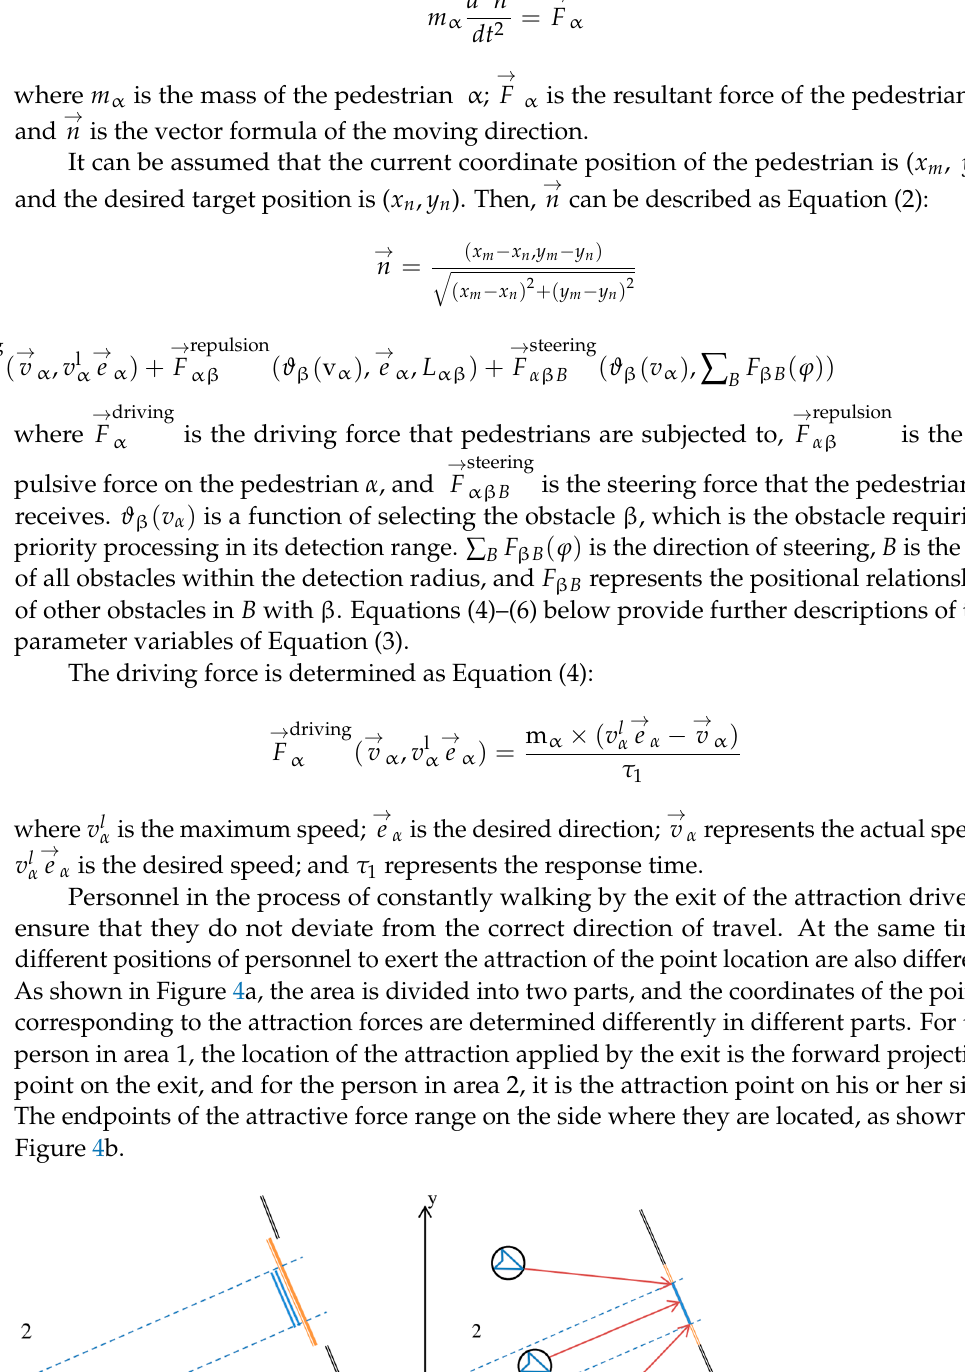
( d ) Figure 4. Schematic diagram of force. ( a ) Human location according to export; ( b ) export attrac- tiveness; ( c ) application of reject force; ( d ) angle of deflection. The endpoints of the attractive force range on the side where they are located, as shown in Figure 4b. The repulsive force is applied to prevent collisions, and the magni- tude of the applied force is related to the position of the pedestrian 𝛼 with respect to the blocking object β relative to their position. As shown in Figure 4c, the radius of the circular obstacle plus the concentric dashed circle of the radius of the personnel The direction of travel of the personnel is 𝑒⃗ (cid:3080) ; moreover, in order to avoid collision with the obstacle with- out turning to avoid the premise, it is necessary to decelerate to zero within a distance 𝐿 (cid:3080)(cid:3081) . The repulsive force can be described as Equation (5). 𝐹⃗ (cid:3080)(cid:3081)(cid:2928)(cid:2915)(cid:2926)(cid:2931)(cid:2922)(cid:2929)(cid:2919)(cid:2925)(cid:2924) (cid:3435)𝜗 (cid:3081) (cid:4666)𝑣⃗ (cid:3080) (cid:4667), 𝑒⃗ (cid:3080) , 𝐿 (cid:3080)(cid:3081) , 𝑡(cid:3439) = − (cid:3421) 2𝐿 (cid:2961)(cid:2962) 𝑚 (cid:2961) (cid:4666)𝜏 (cid:2869) + 𝜏 (cid:2870) (cid:4667) (cid:2870) − 𝐹⃗ (cid:3080)(cid:2914)(cid:2928)(cid:2919)(cid:2932)(cid:2919)(cid:2924)(cid:2917) ⋅ 𝑒⃗ (cid:2961) |𝑒⃗ (cid:2961) |